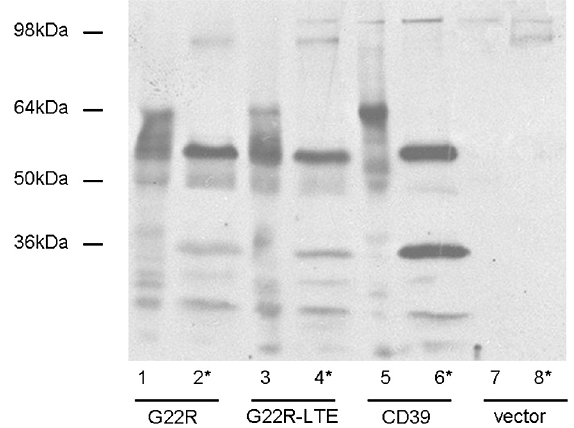
Figure 5 . Expression of wtCD39, and the G22R and G22R-LTE (L489L, M492T, G496E) mutants in yeast. A total of 15 μ g of crude membrane proteins of samples pVT101-CD39G22R (lanes 1 – 2), pVT101-CD39 G22R-LTE (lines 3 – 4), pVT101-CD39 (lanes 5 – 6), and pVT101 (lanes 7 – 8) were treated (*) or not treated with glycopeptidase F. The samples were subjected to 7.5% SDS-PAGE and examined by immunoblotting with anti-HA11 monoclonal